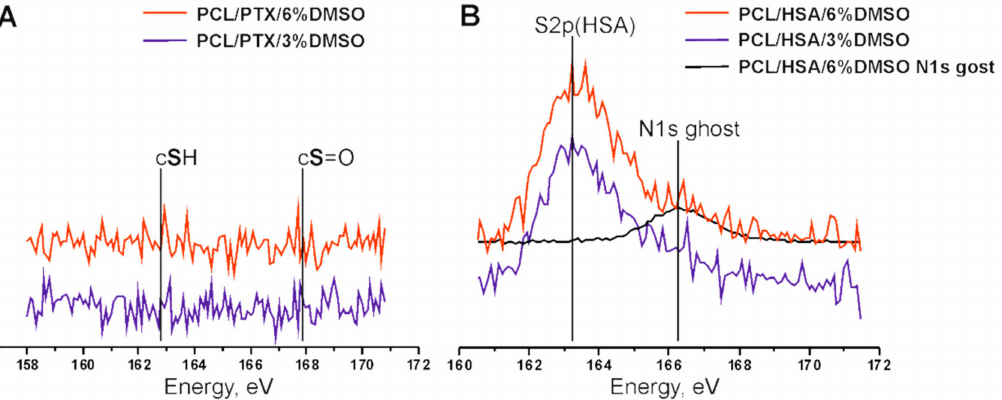
Figure 2. XPS spectra of the samples PCL/PTX/DMSO ( A ) and PCL/HSA/DMSO ( B ).